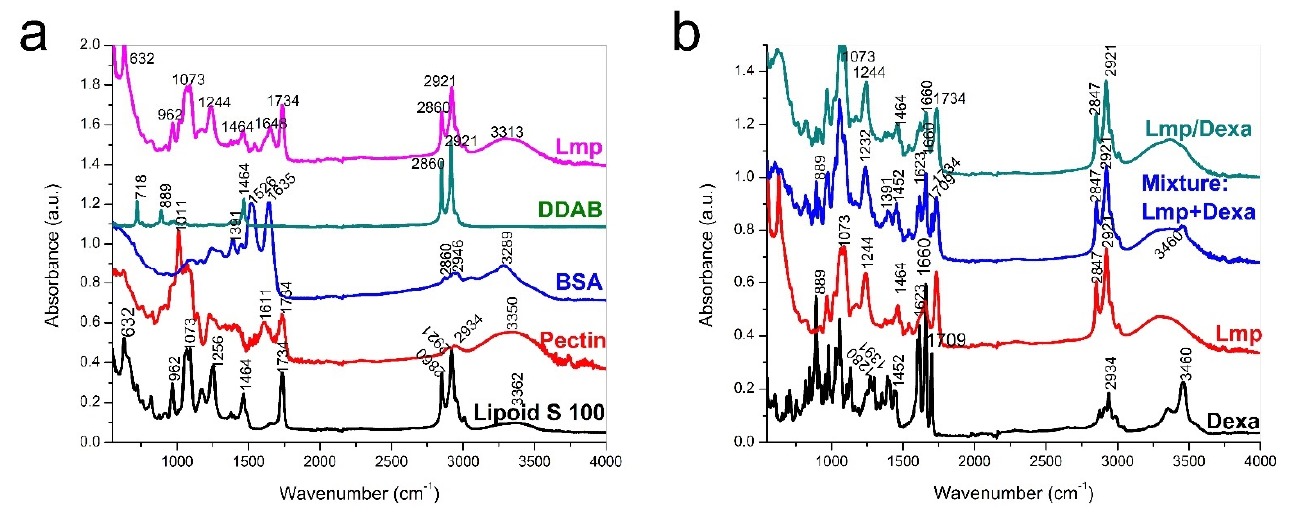
Figure 1. Overlapped FTIR spectra of: Lmp and the precursors (Lipoid S 100, P, BSA and DDAB) used for Lmp synthesis ( a ); pure Dexa, Lmp, Physical mixture of Lmp + Dexa and Lmp/Dexa ( b